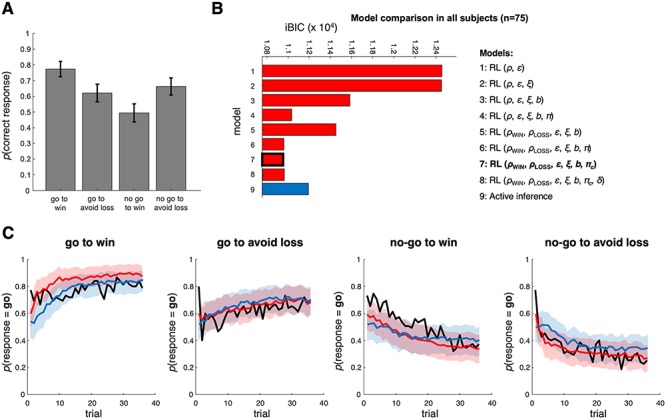
Performance and model comparison across all participants (n = 75). (A) The probability of making a correct response in each condition across all participants and trials. Participants do best in the ‘Pavlovian’ conditions, go to win and no-go to avoid loss. Error bars depict the standard error of the mean. (B) Model comparison across all participants using the integrated BIC (see text). Model 7 is the best model; AI is fifth. The RL model parameters shown here included: reward and loss sensitivities \documentclass[12pt]{minimal}
\usepackage{amsmath}
\usepackage{wasysym} 
\usepackage{amsfonts} 
\usepackage{amssymb} 
\usepackage{amsbsy}
\usepackage{upgreek}
\usepackage{mathrsfs}
\setlength{\oddsidemargin}{-69pt}
\begin{document}
}{}${\rho}$\end{document}win and \documentclass[12pt]{minimal}
\usepackage{amsmath}
\usepackage{wasysym} 
\usepackage{amsfonts} 
\usepackage{amssymb} 
\usepackage{amsbsy}
\usepackage{upgreek}
\usepackage{mathrsfs}
\setlength{\oddsidemargin}{-69pt}
\begin{document}
}{}${\rho}$\end{document}loss, learning rate \documentclass[12pt]{minimal}
\usepackage{amsmath}
\usepackage{wasysym} 
\usepackage{amsfonts} 
\usepackage{amssymb} 
\usepackage{amsbsy}
\usepackage{upgreek}
\usepackage{mathrsfs}
\setlength{\oddsidemargin}{-69pt}
\begin{document}
}{}$\varepsilon$\end{document}, irreducible noise \documentclass[12pt]{minimal}
\usepackage{amsmath}
\usepackage{wasysym} 
\usepackage{amsfonts} 
\usepackage{amssymb} 
\usepackage{amsbsy}
\usepackage{upgreek}
\usepackage{mathrsfs}
\setlength{\oddsidemargin}{-69pt}
\begin{document}
}{}$\xi$\end{document}, go bias \documentclass[12pt]{minimal}
\usepackage{amsmath}
\usepackage{wasysym} 
\usepackage{amsfonts} 
\usepackage{amssymb} 
\usepackage{amsbsy}
\usepackage{upgreek}
\usepackage{mathrsfs}
\setlength{\oddsidemargin}{-69pt}
\begin{document}
}{}$b$\end{document}, different forms of Pavlovian bias (see Methods), \documentclass[12pt]{minimal}
\usepackage{amsmath}
\usepackage{wasysym} 
\usepackage{amsfonts} 
\usepackage{amssymb} 
\usepackage{amsbsy}
\usepackage{upgreek}
\usepackage{mathrsfs}
\setlength{\oddsidemargin}{-69pt}
\begin{document}
}{}$\pi$\end{document} and \documentclass[12pt]{minimal}
\usepackage{amsmath}
\usepackage{wasysym} 
\usepackage{amsfonts} 
\usepackage{amssymb} 
\usepackage{amsbsy}
\usepackage{upgreek}
\usepackage{mathrsfs}
\setlength{\oddsidemargin}{-69pt}
\begin{document}
}{}${\pi}_c$\end{document}, and decay rate \documentclass[12pt]{minimal}
\usepackage{amsmath}
\usepackage{wasysym} 
\usepackage{amsfonts} 
\usepackage{amssymb} 
\usepackage{amsbsy}
\usepackage{upgreek}
\usepackage{mathrsfs}
\setlength{\oddsidemargin}{-69pt}
\begin{document}
}{}$\delta$\end{document}. The AI model parameters are listed in Table 1 and Figure 2B. (C) These plots compare the actual probability of participants’ go responses (group averaged data) with model predictions in each condition. The probability of go responses is plotted in black. To create the model predictions, each model simulated responses using each participant’s estimated parameters 20 times, that is, 1500 times in total. The responses were then averaged and plotted in red (RL – Model 7) and blue (AI – Model 9) lines. 95% confidence intervals for the means of the simulations (shaded areas) were derived from the distributions of means of 100 samples of n = 75 participants.